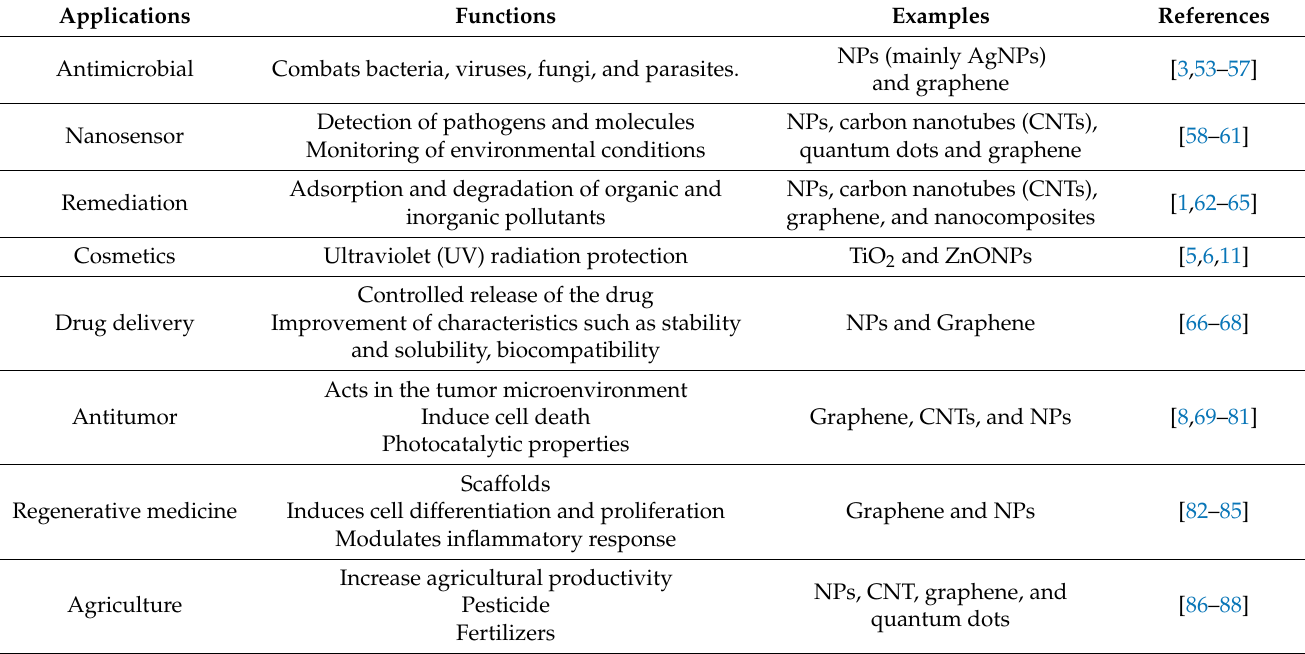
Table 1. Examples of different applications of nanomaterials involving biological